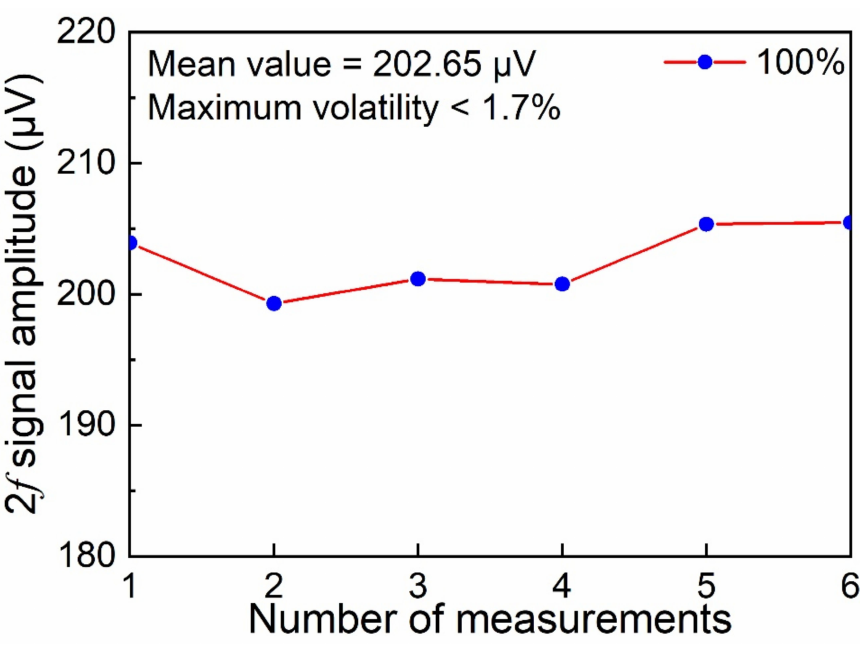
Figure 5. The 2 f signal for TDLAS sensor with different concentrations of H 2 for H 2 -TDLAS sensing Figure 7. The 2 f signal repeatability at 100% H 2 concentration for the H 2 -TDLAS sensing system. system.